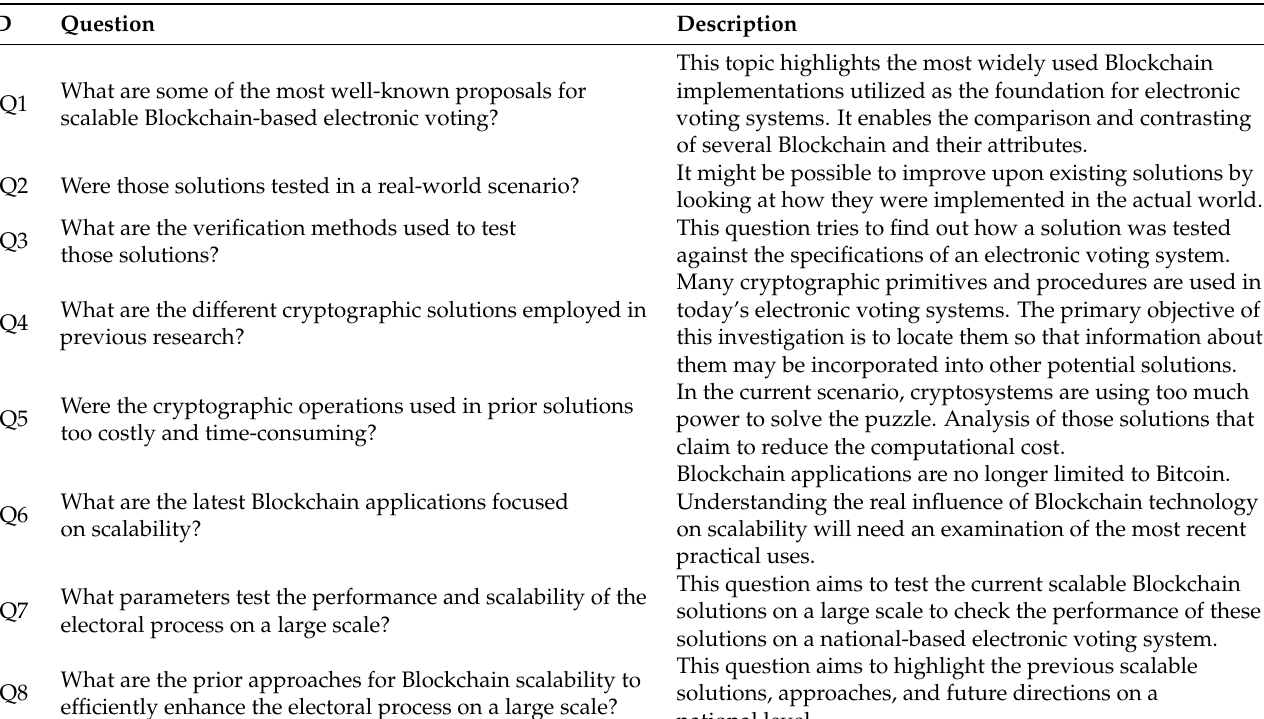
Table 2. Research questions